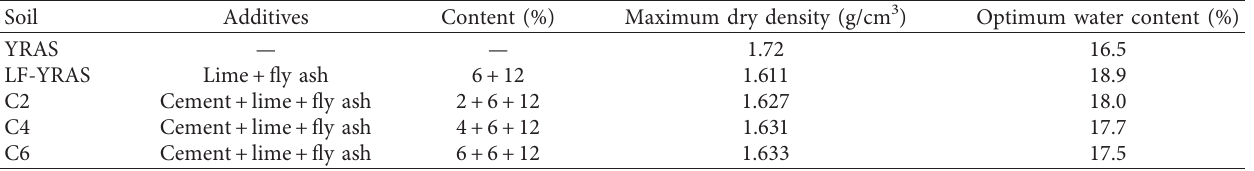
Table 4: Compaction test results of